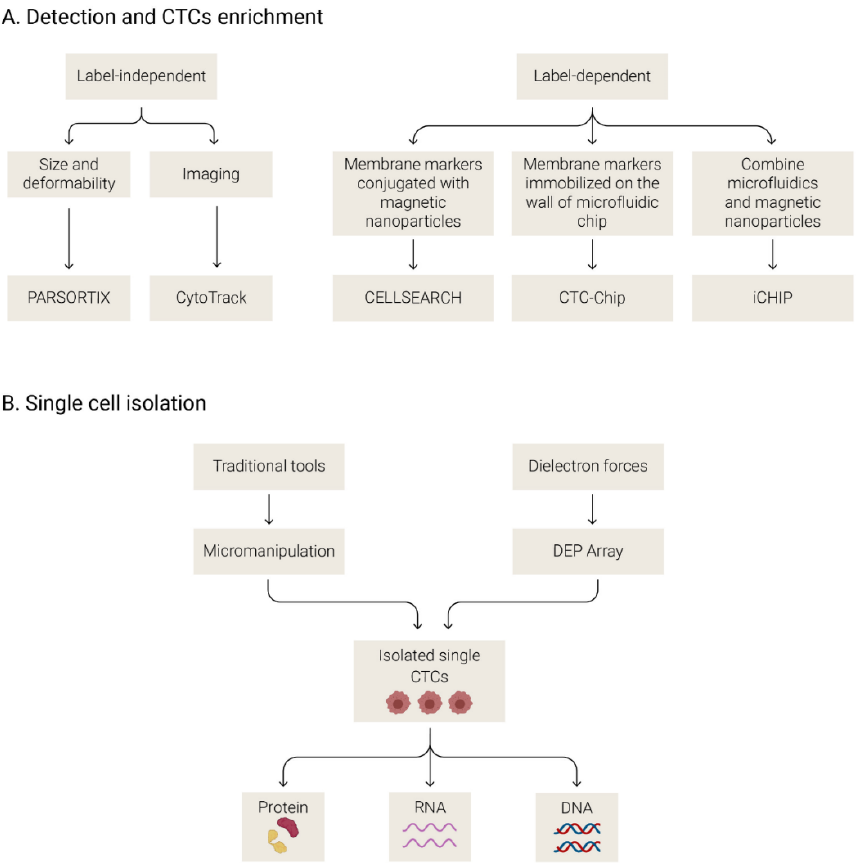
Figure 3. Different strategies for circulating tumor cells enrichment and detection ( A ) and single cell isolation ( B ).